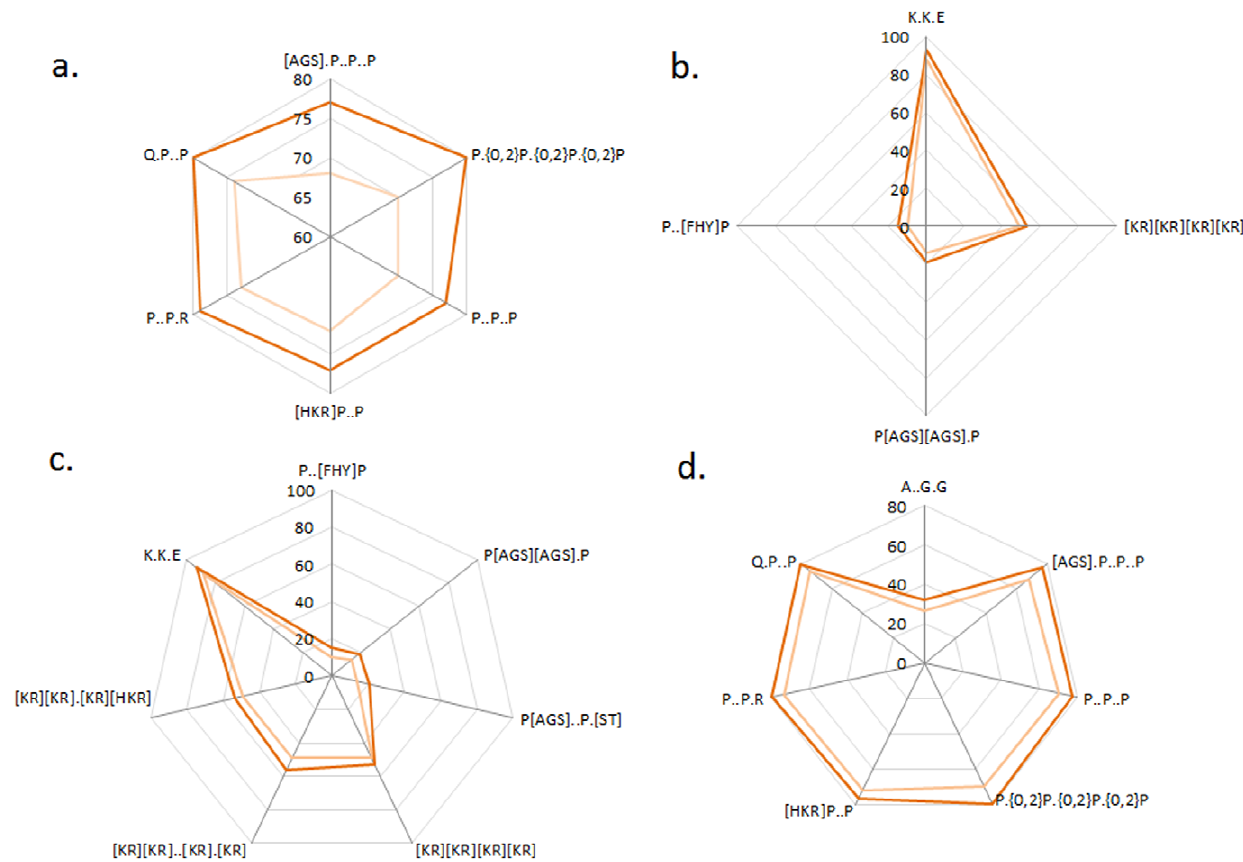
Figure 1. Radar graphs visualizing predicted motifs positions on NEF and TAT. The radar graph illustrating the computationally predicted motifs on Nef for binding to SRC (1a, 1c) and Tat for binding to EP300 (1b, 1d) at p value cut offs of 0.005 for 1a and 1b and 0.01 for 1c and 1d. The radial distance indicates amino acid residue number on the HIV protein sequence starting from the N terminal. Edges of hotspots are marked with orange lines.